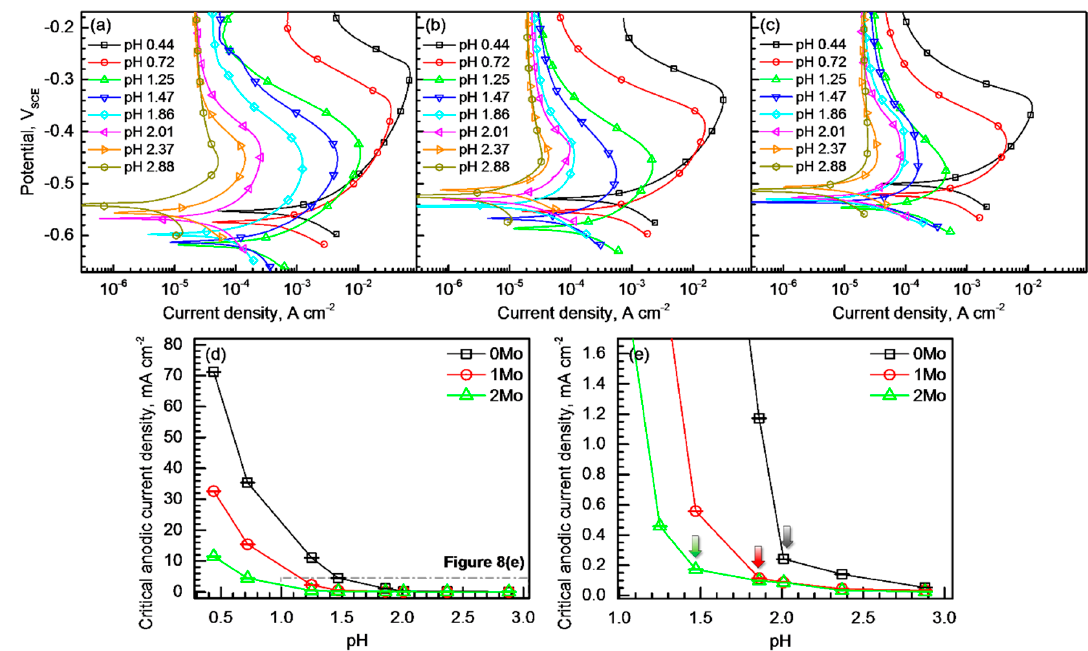
Figure 8. Potentiodynamic polarization curves of ( a ) 0Mo, ( b ) 1Mo, and ( c ) 2Mo alloys measured in 4 M NaCl + HCl solutions with different solution pHs of 0.44–2.88 at 25 °C (d V /d t = 1 mV/s). ( d ) Graphs of average critical anodic current density values with standard deviation (scatter band) of the alloys versus solution pH. ( e ) A magnified part of graphs in Figure 7d.